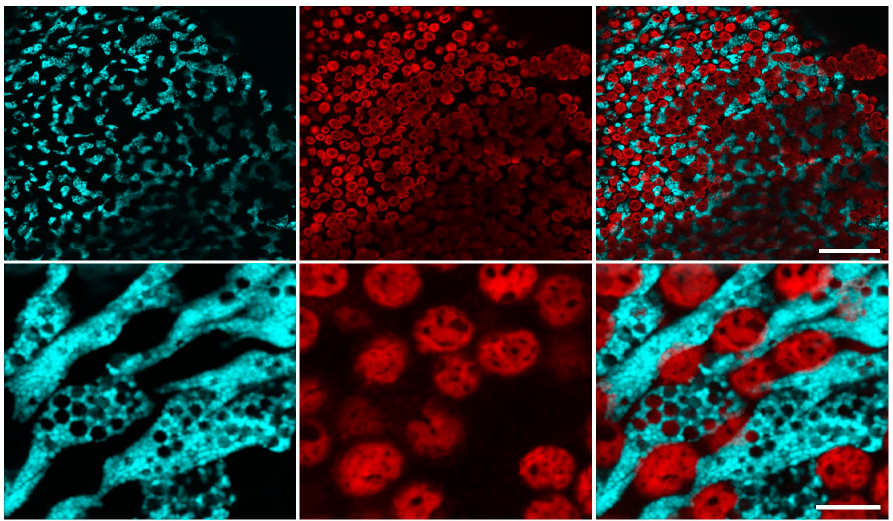
Figure 3. Confocal microscopy of live Clavularia tentacle tissues. ( A ) Cyan fluorescence (excitation 458 nm, detection 470–535 nm); ( B ) red fluorescence (excitation 543 nm, detection 570–670 nm). Scale bars: upper row, − 50 µm; bottom row, − 10 µm.